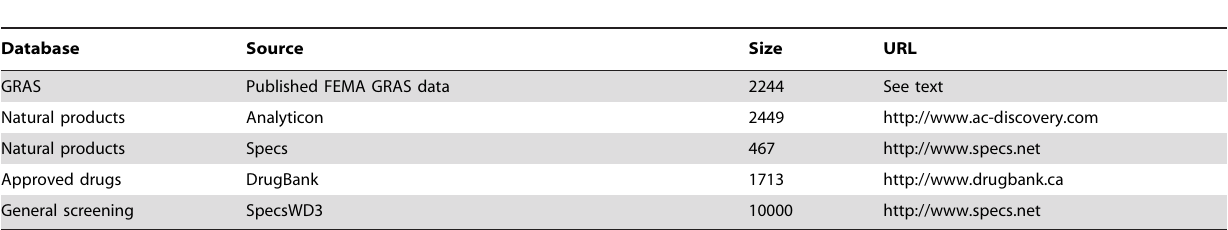
Table 1. Compound databases analyzed in this